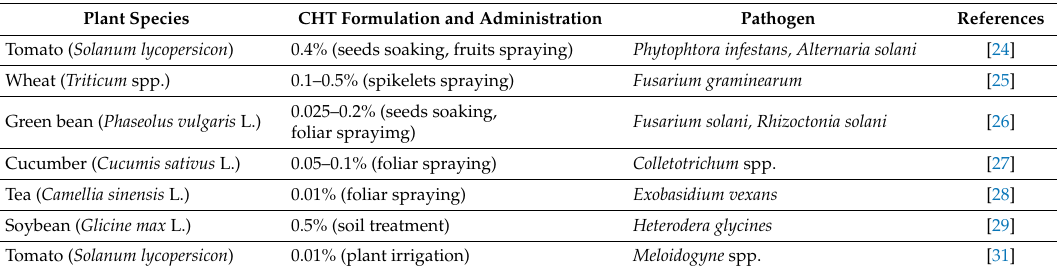
Table 2. CHT effects on plant